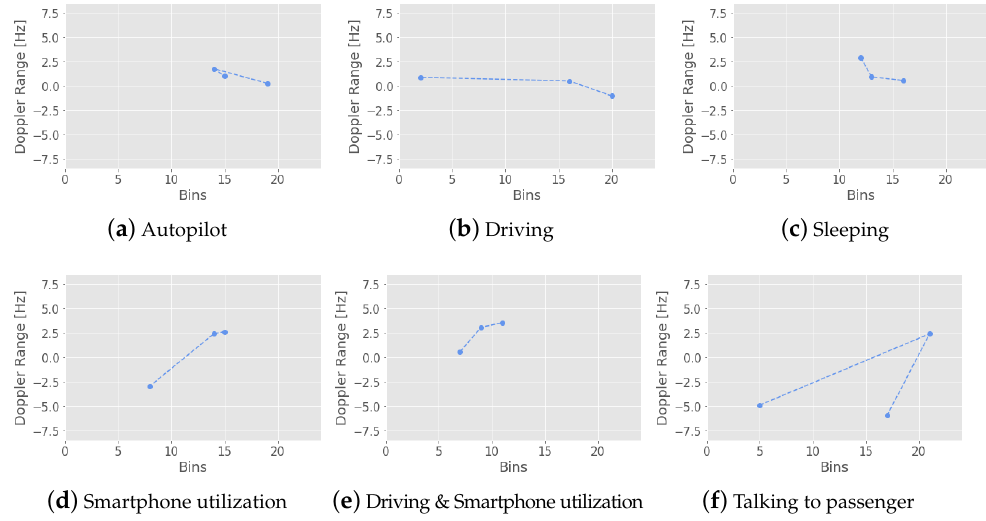
Figure 6. Range-Doppler trajectories of six ( a – f ) in-cabin activities calculated using the method of [32]. Each trajectory contains a single frame (0.34